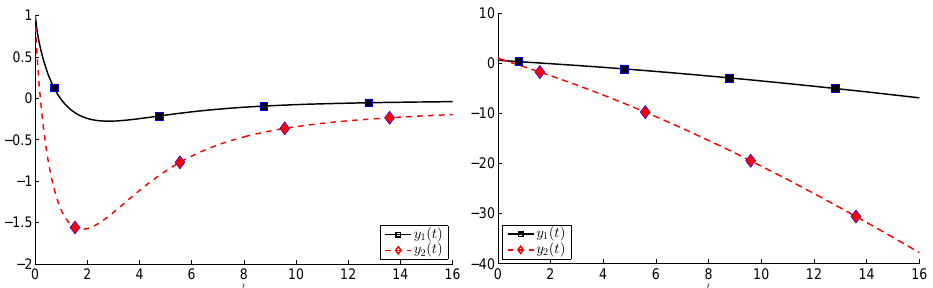
Figure 5. Asymptotically stable solutions of system (18) when q = ( 0.8,0.8 ) ( left plot) and unstable solutions when q = ( 0.2,1 ) ( right plot).